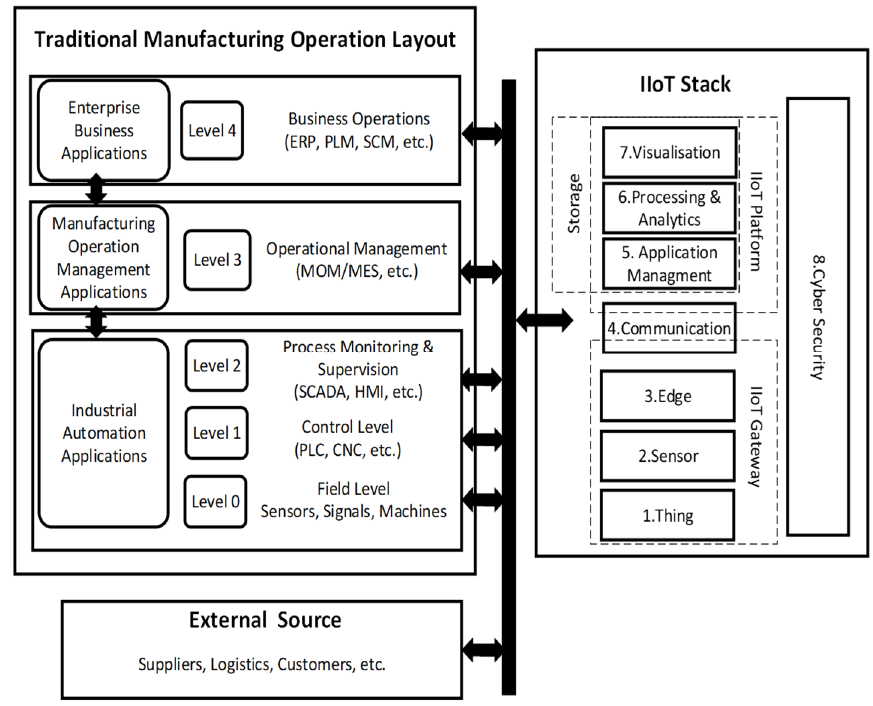
Figure 10. Manufacturing operation levels and IIoT integration architecture. (Author’s creation).